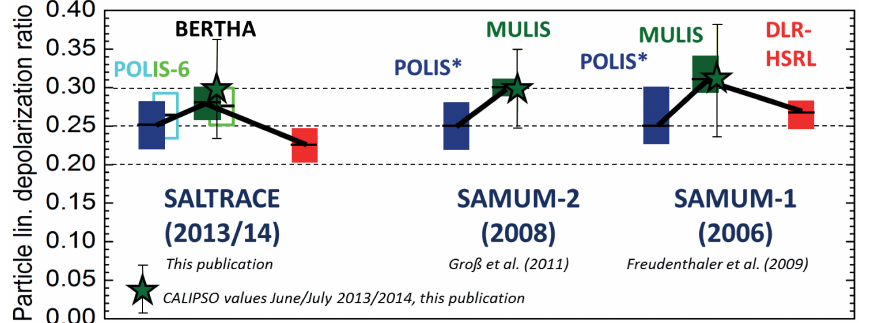
Figure 14. Comparison of dust-layer mean particle linear depolarization ratios measured during SAMUM-1 (Morocco), SAMUM-2 (Cabo Verde), and SALTRACE (Barbados). Colored bars show the range of mostly observed depolarization ratios at 355nm (blue), 532nm (green), and 1064nm (red). The lidars BERTHA, POLIS, and MULIS (the second polarization lidar of Munich University) and the airborne high- spectral-resolution lidar (HSRL) of DLR (Deutsches Zentrum für Luft- und Raumfahrt) were used to collect this data set. Data are taken from the publications of Freudenthaler et al. (2009, SAMUM-1, 19 cases for MULIS, 2–4 cases for the other systems), Groß et al. (2011a, SAMUM-2, 9 cases for POLIS, 5 cases for MULIS), Groß et al. (2015, SALTRACE, POLIS-6), and from this study (21 cases). In addition, CALIOP mean values of SAL column depolarization ratios considering all observations during the 4 SALTRACE months (June and July in 2013 and 2014) are shown. The mean values consider all CALIOP overpasses of selected areas in southeastern Morocco, in the Cabo Verde region, and around Barbados during these 4 months.